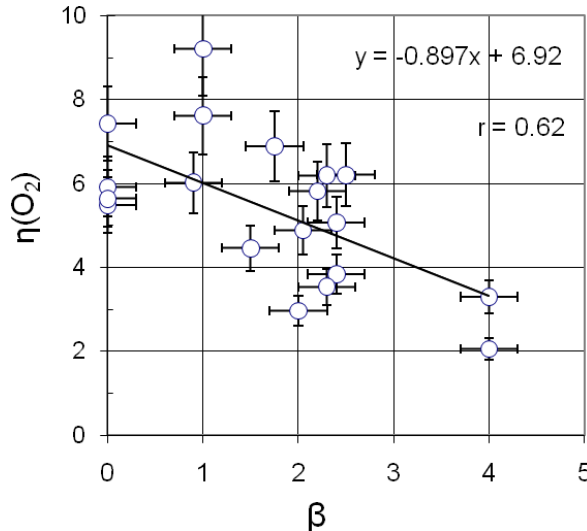
Fig. 7. Relation between the Krassovsky parameters ( η) and damp- ing rates ( β) of the O 2 emission. The straight line is a linear regres- sion curve and “ r ” indicates the correlation